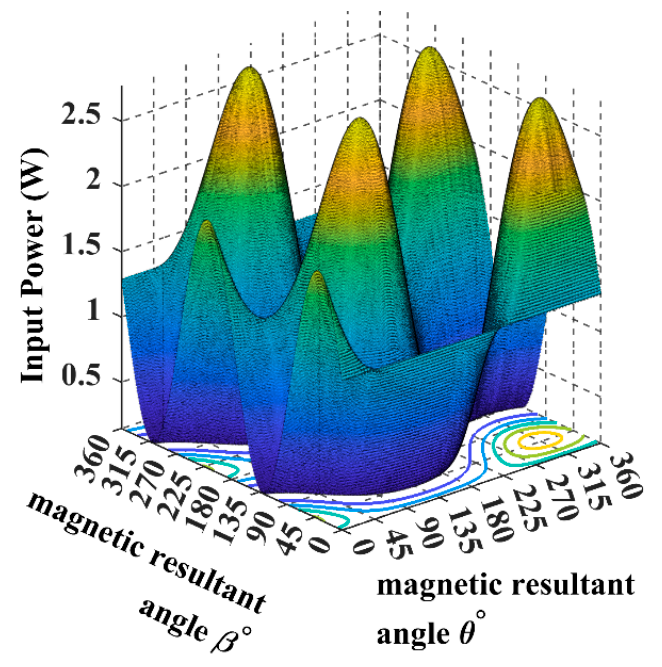
Figure 14. The input power plot for the 3D WPT system when the receiver is placed at α = φ = 135°. By observing Figures 11 and 15, we can understand that both the receiver spherical positions when α = φ = 45 ◦ , α = φ = 135 ◦ produce the same input power of 2.5 W. However, the flow direction of the input power is focused on the 135 ◦ axis in the 3D